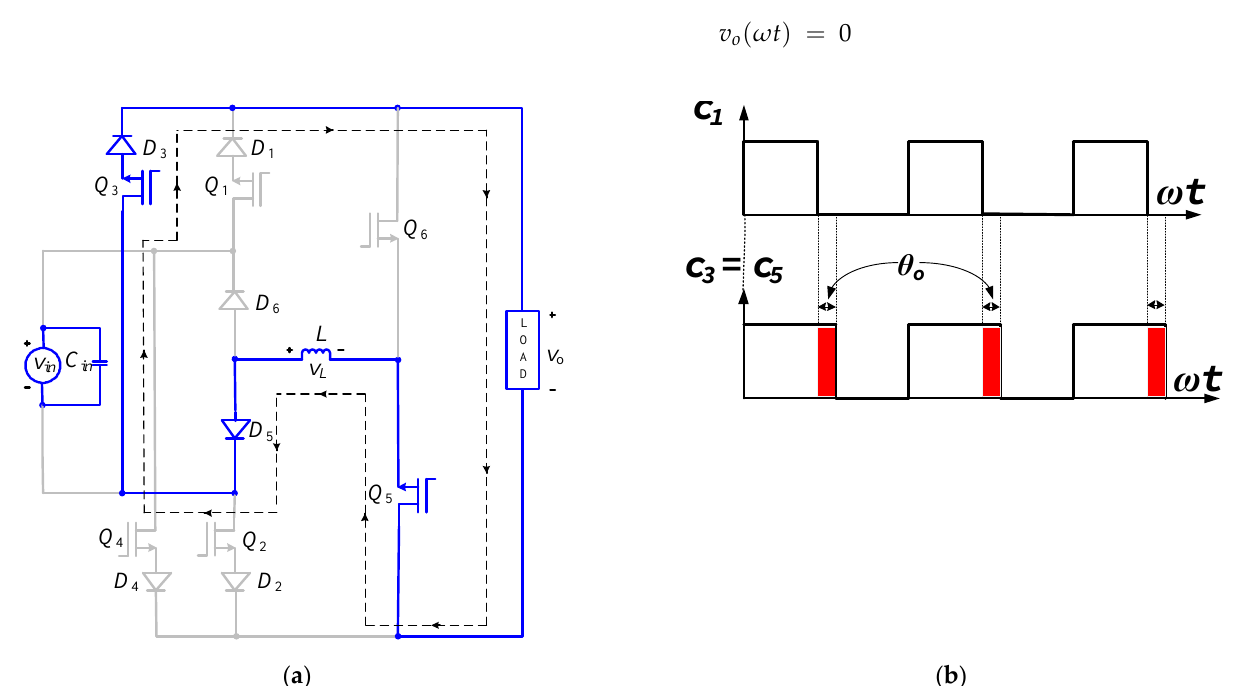
Figure 7. Elimination of inductor current interruption during the off state: ( a ) closed current loop to de-energize the inductor; ( b ) corresponding switching signals.